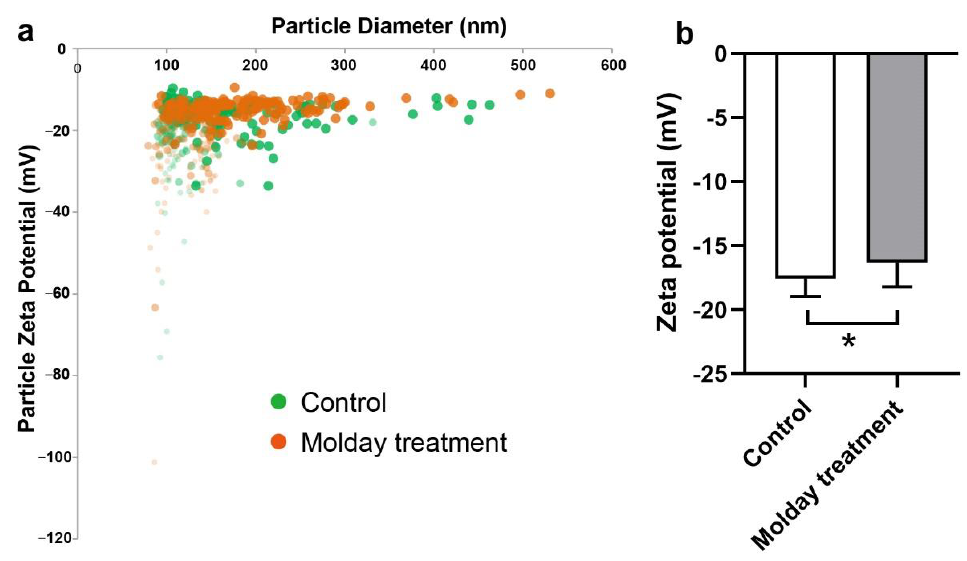
Figure 3. Zeta potential comparison of control hMSC-EVs and Molday ION-treated hMSC-EVs: ( a ) Zeta potential distribution of EVs derived from control and Molday ION-treated hMSCs. ( b ) Zeta potential comparison of hMSC-EV control group (n = 6) and Molday ION treated hMSC-EV group (n = 8). * Significant difference between treatment groups.